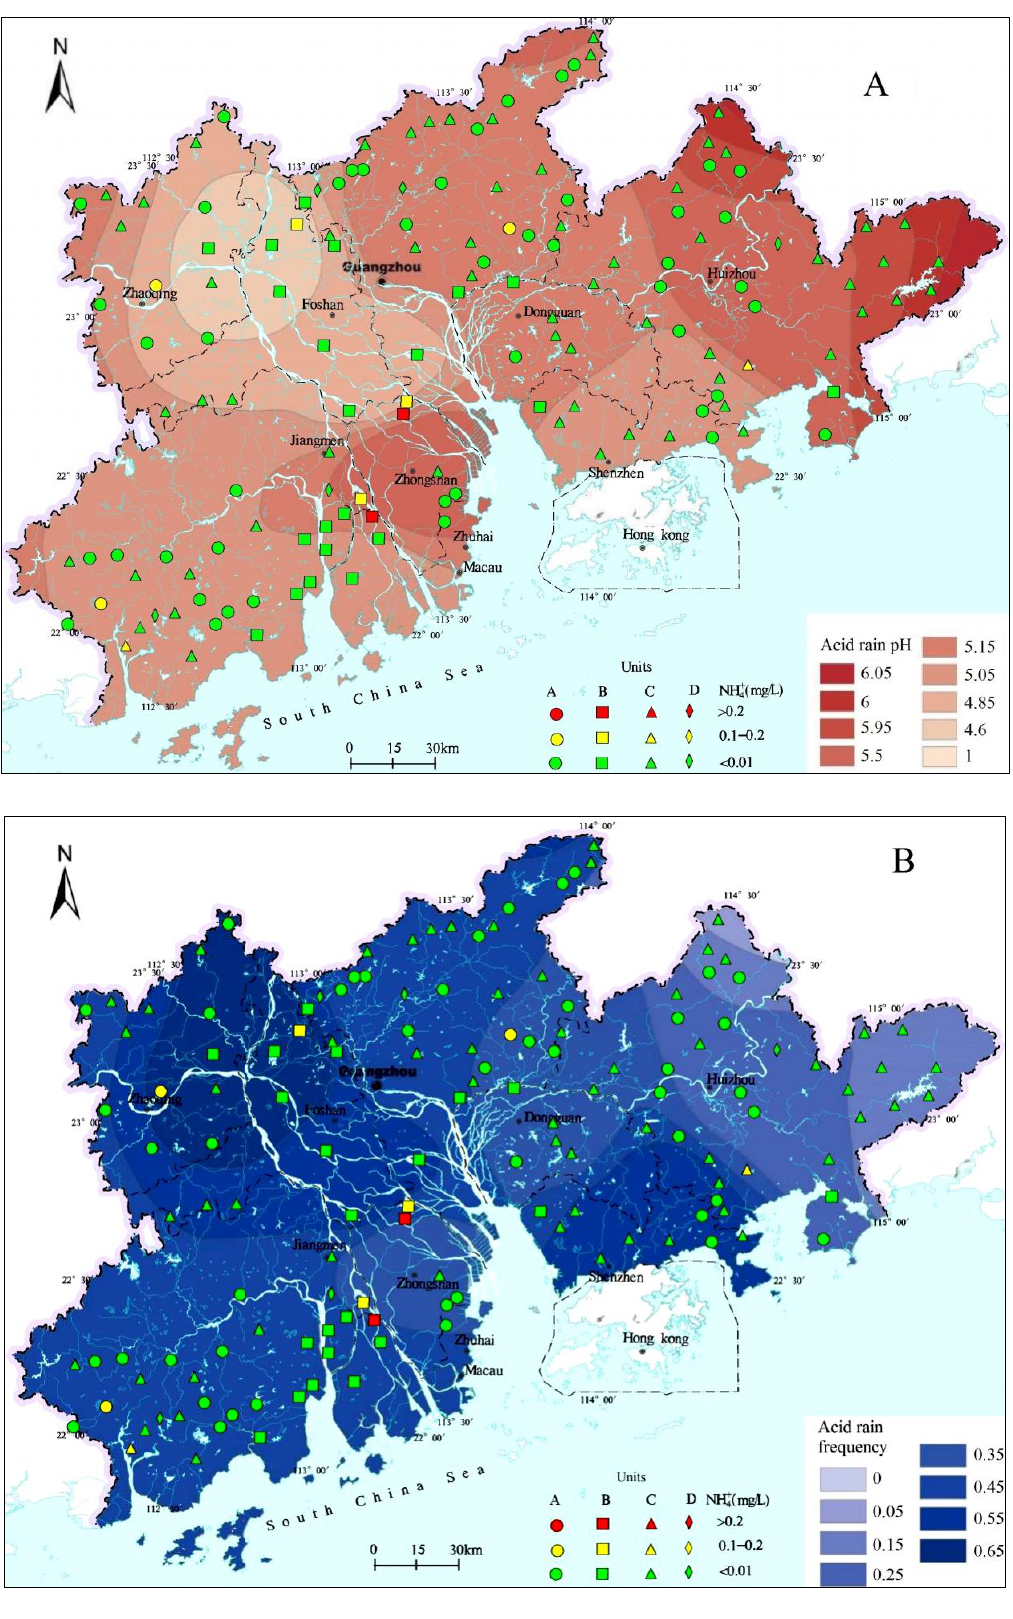
Figure 3. Distribution of NH 4+ in various groundwater units in residual datasets and acid rain data for the Pearl River Delta (data of acid rain from Liu et al. [23]). ( A ) is acid rain pH, and ( B ) is acid rain frequency.